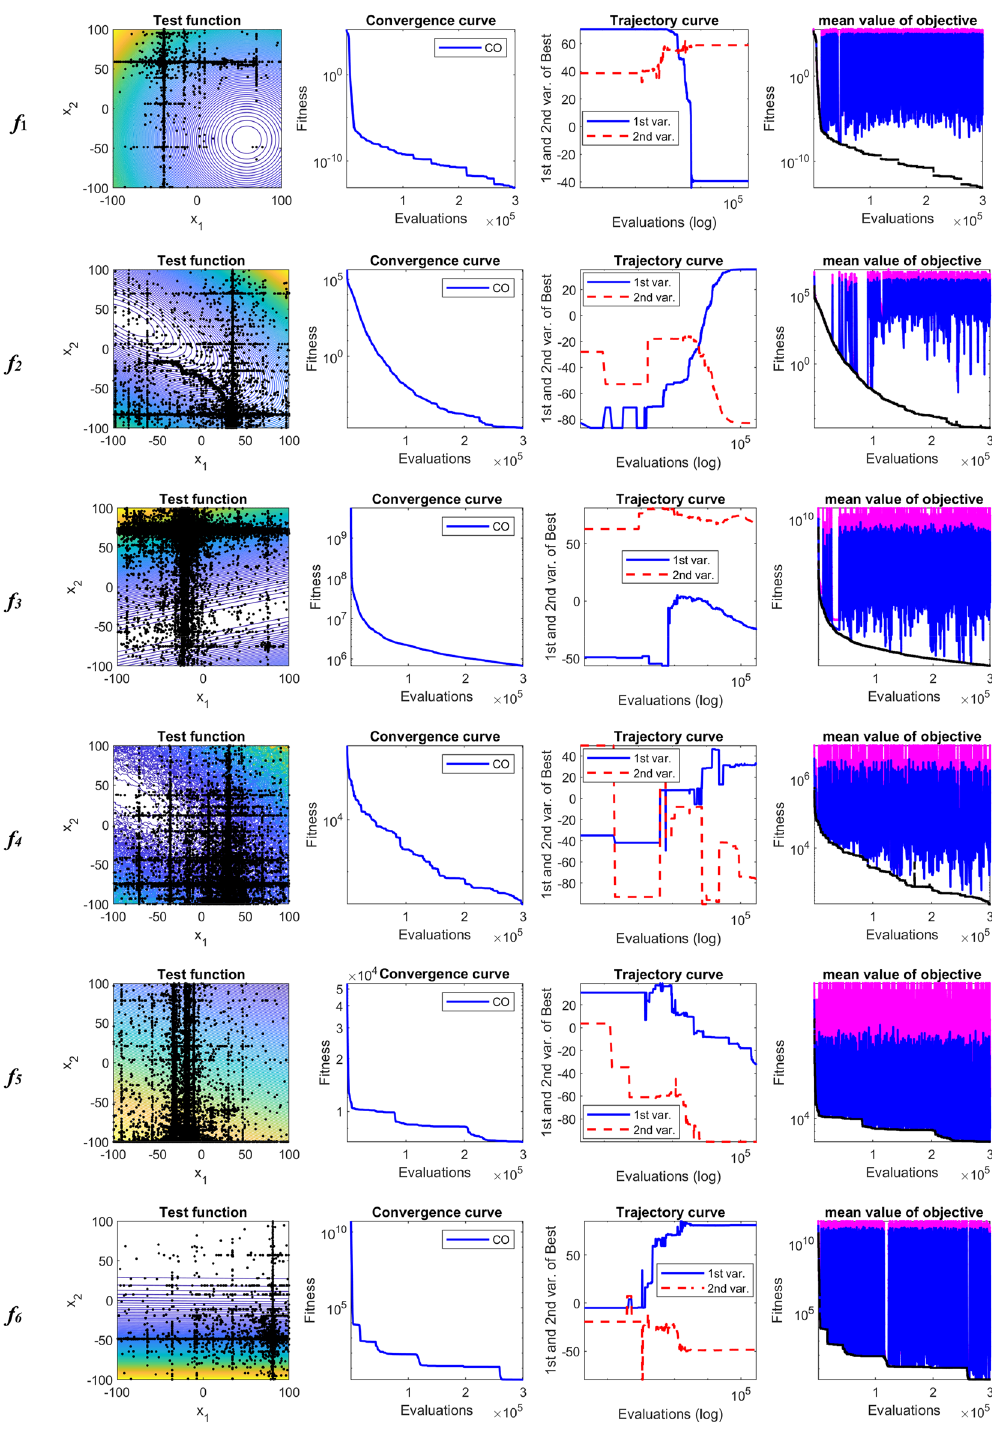
Figure 3. Convergence characteristics of CO on shifted-rotated CEC2005 benchmark